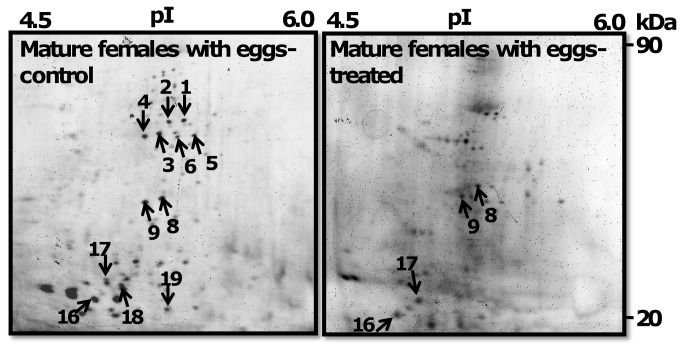
Mature female’s 2-DE gel treated with phosphatase showing dephosphorylated spots.300 µg proteins were incubated without (control) or with (treated) 400 U ƛ-PPase and separated by 2-DE (pH range 4–7). Phosphorylated proteins (arrow heads) were detected by Pro-Q Diamond phosphoprotein stain. The treated gel shows the spot pattern in the presence of ƛ-phosphatase. Spot numbers are corresponding to proteins listed in Table 1.